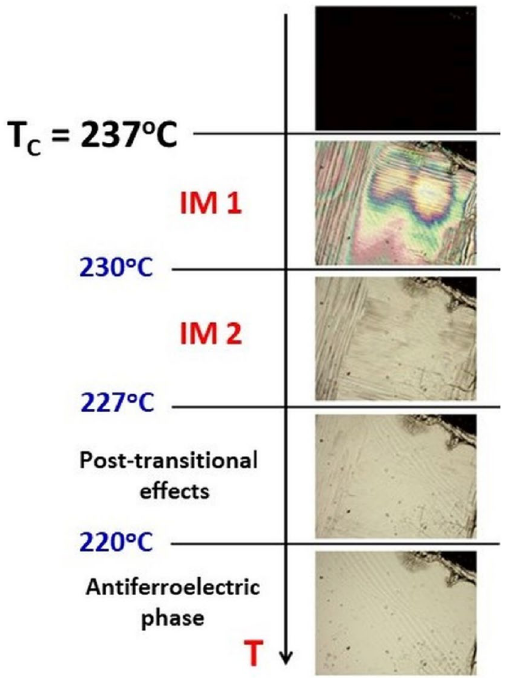
Figure 3. Images for PZO:1%Nb single crystal at selected temperatures under the polarised microscope. Domain structure disappears at T C , which correlates with a maximum permittivity 10 . IM1 and IM2 denote intermediate phases. Image size is c.a. 1.5 × 2 mm 2